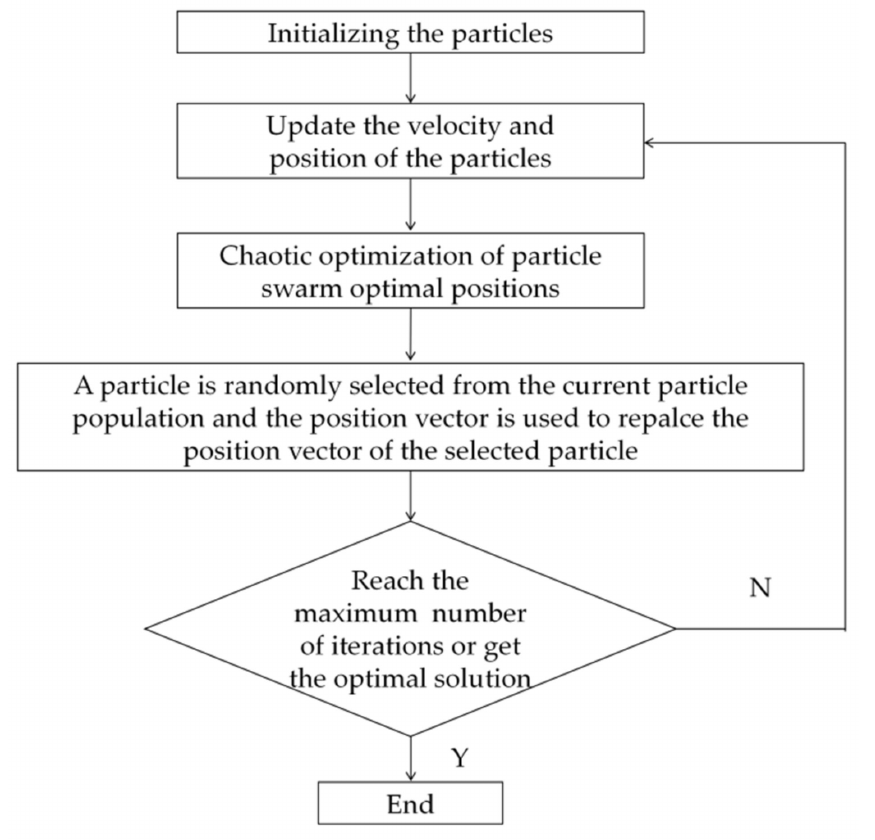
Figure 1. CPSO algorithm flow